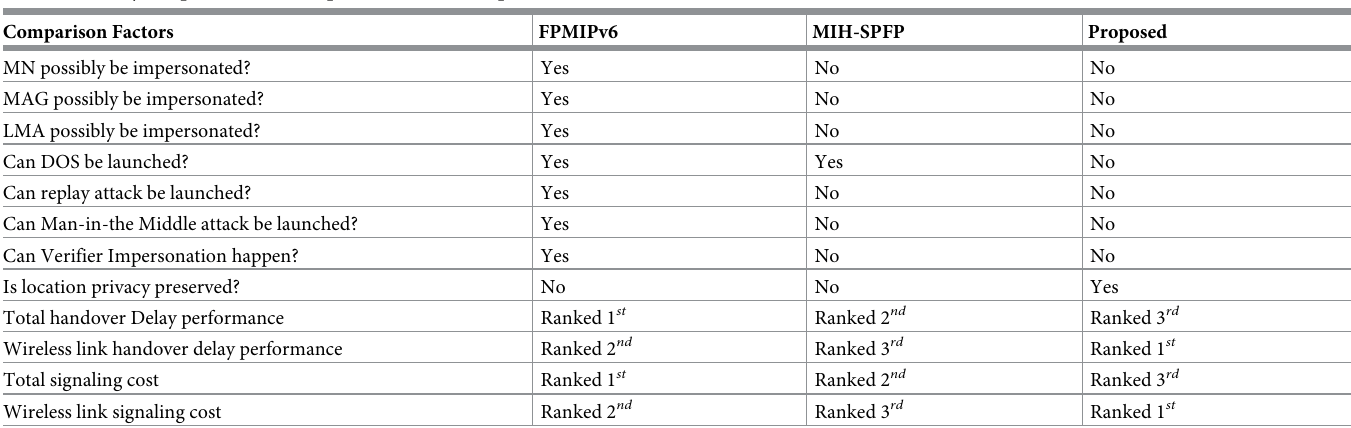
Table 4. Security and performance comparison of handover